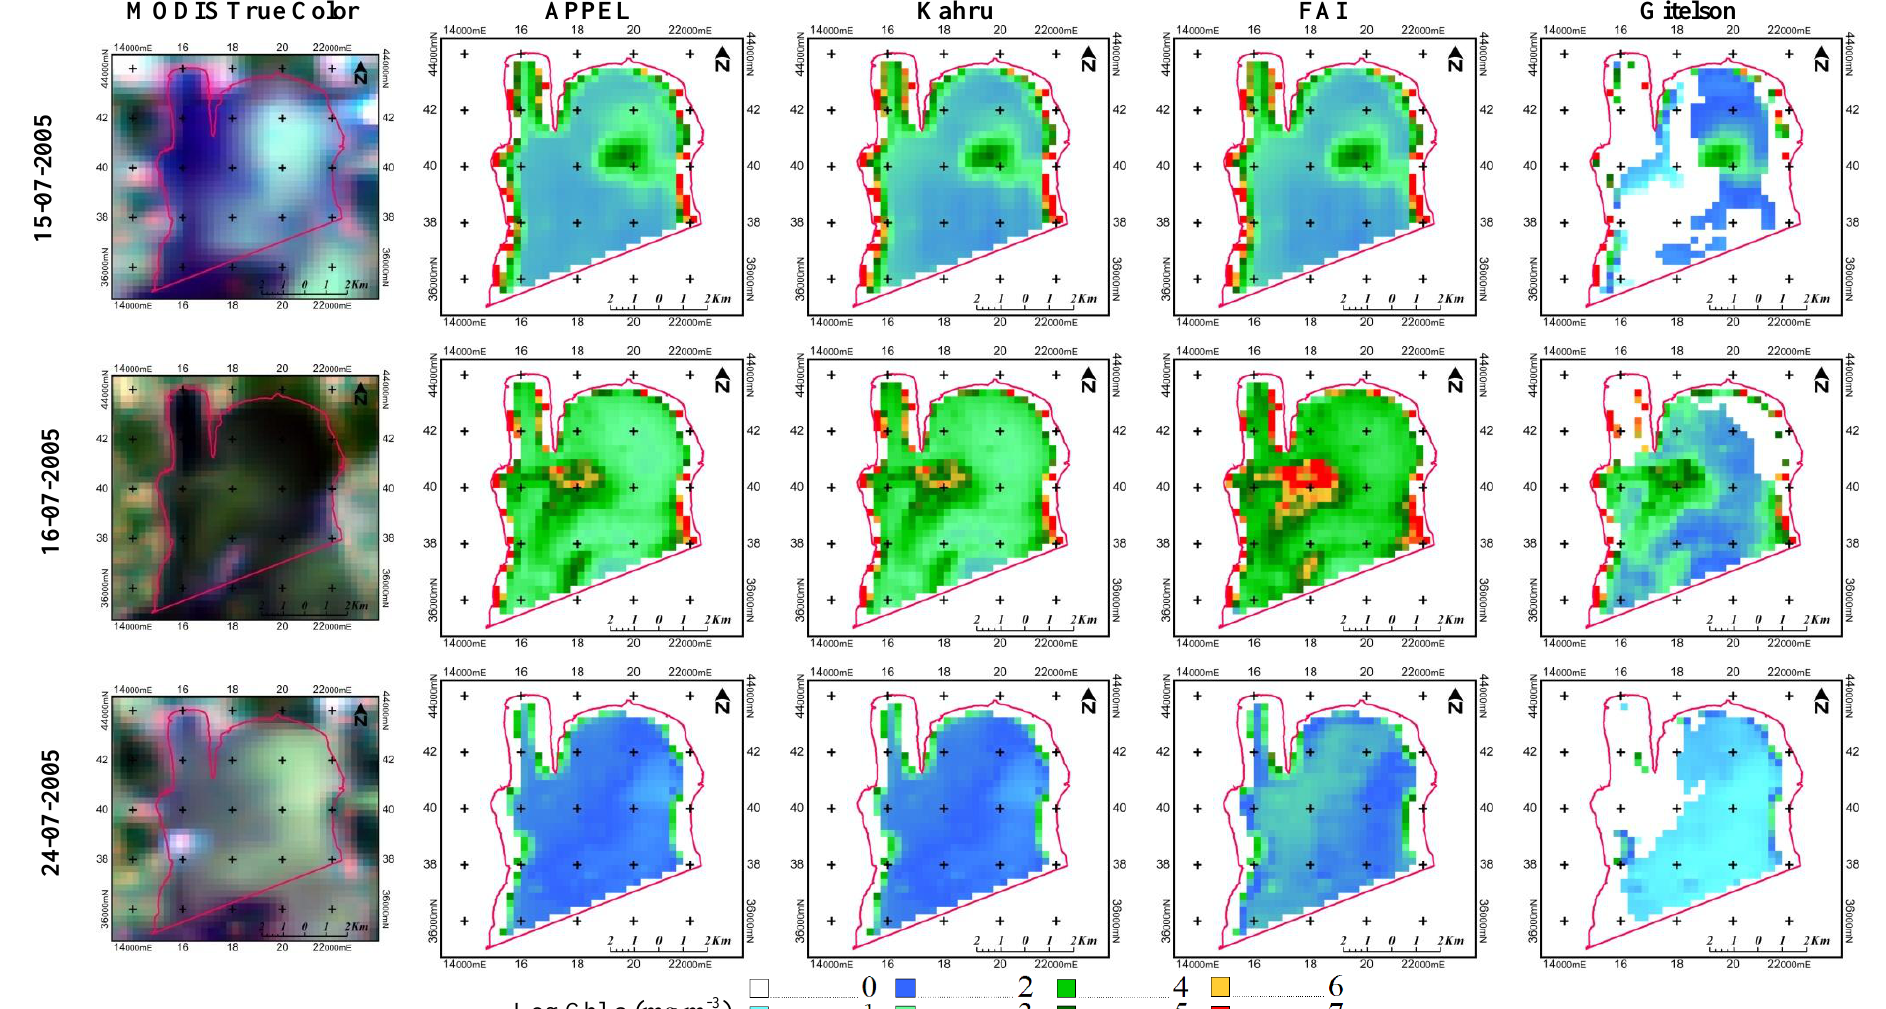
Figure 12. MODIS images of Missisquoi Bay on Lake Champlain on three dates and corresponding estimates of chlorophyll-a concentration by the four